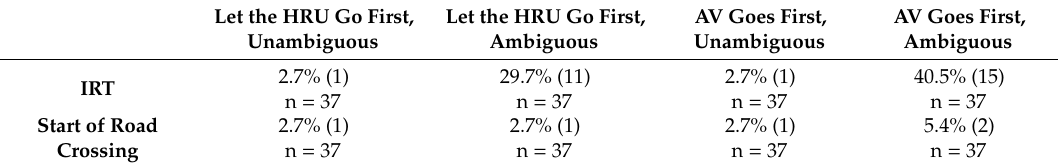
Table 13. Misinterpretations of the intentions for the metrics IRT and start of road